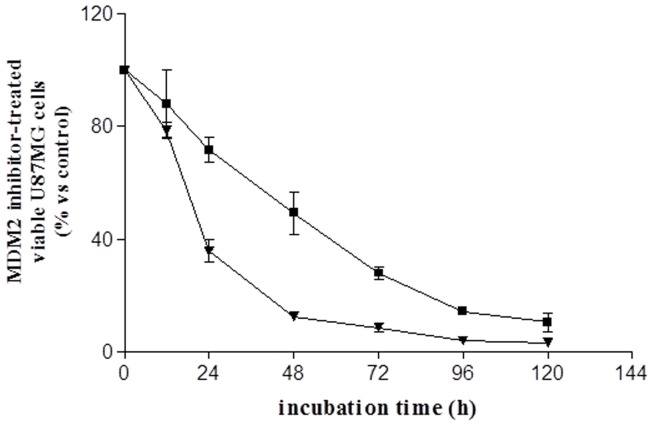
Long-term ISA27 treatment of U87MG cells.U87MG cells were treated with 2.5 µM ISA27 or 10 µM Nutlin-3 for 24, 48, 72, 96 and 120 h. The figure shows the viable cells that were counted by Trypan blue exclusion at the indicated times. The percentage of ISA27- (▾) or Nutlin-3- (▪) treated viable cells was calculated with respect to untreated viable cells at the indicated incubation times. Points, means of three independent experiments performed in duplicate; bars, SEM.